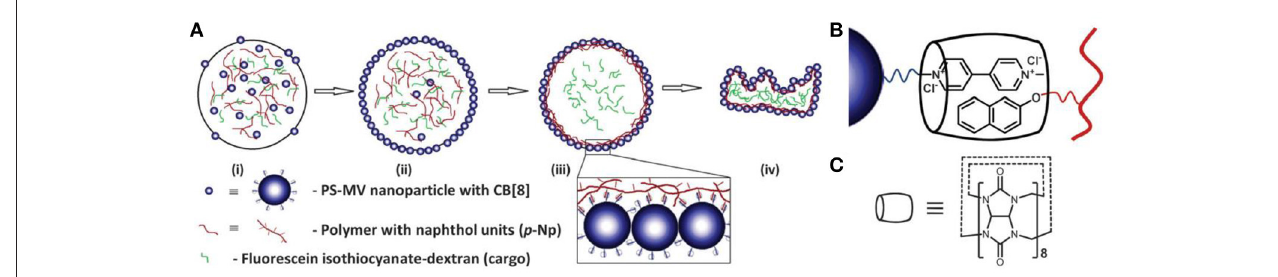
FIGURE 6 | Schematic representation of supramolecular colloidosomes through the interfacially host-guest crosslinking between cucurbi[8]uril (CB[8]), methyl viologen-functionalized polystyrene nanoparticles and naphthol-functionalized polyacrylamide (Stephenson et al., 2014). (A) Schematic of colloidosome formation. (B) Schematic of the ternary supramolecular complex formed between PS-MV, p-Np and CB[8]. (C) The molecular structure of CB[8]. Reprinted with permission from Stephenson et al. (2014). Copyright 2014 The Royal Society of Chemistry.